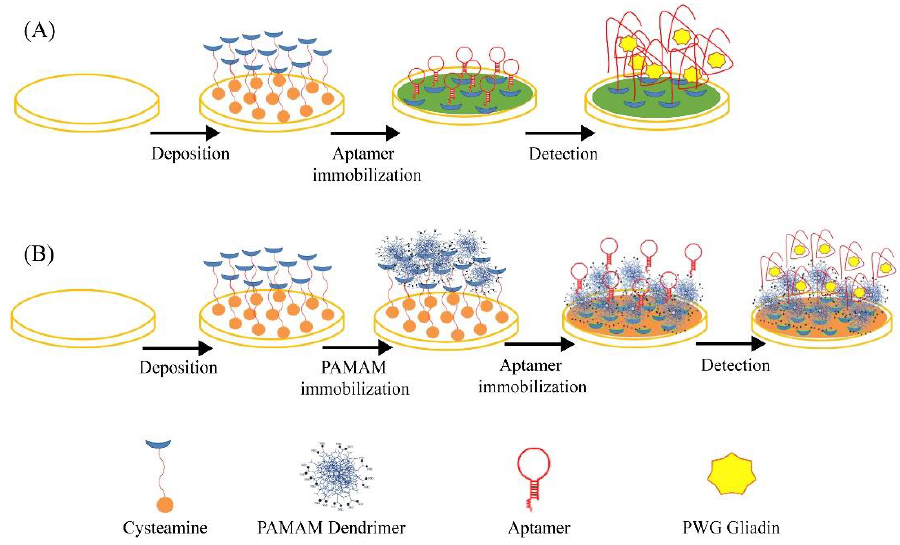
Figure 9. Scheme of the aptasensor ( A ) without PAMAM G4 and ( B ) with PAMAM G4. Reprinted with permission from [126]. Copyright 2017, Elsevier.